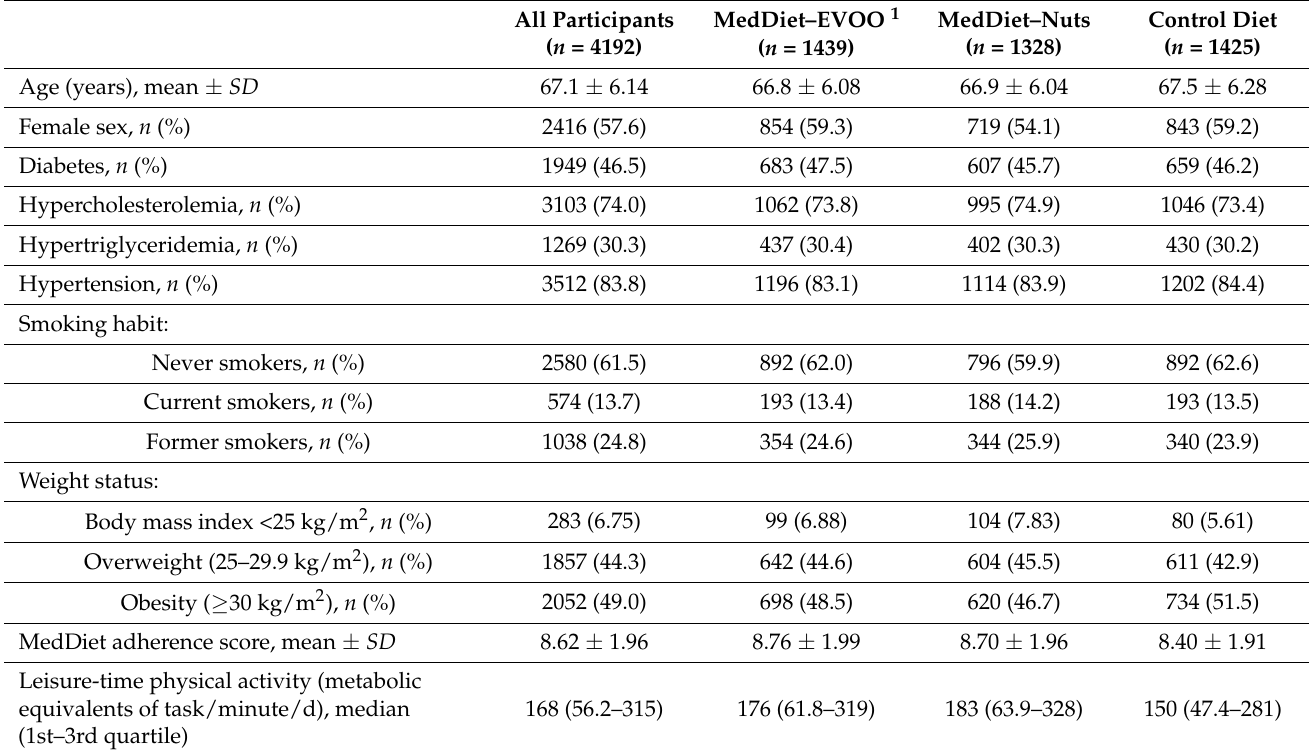
Table 1. Study population ( n = 4192) by intervention